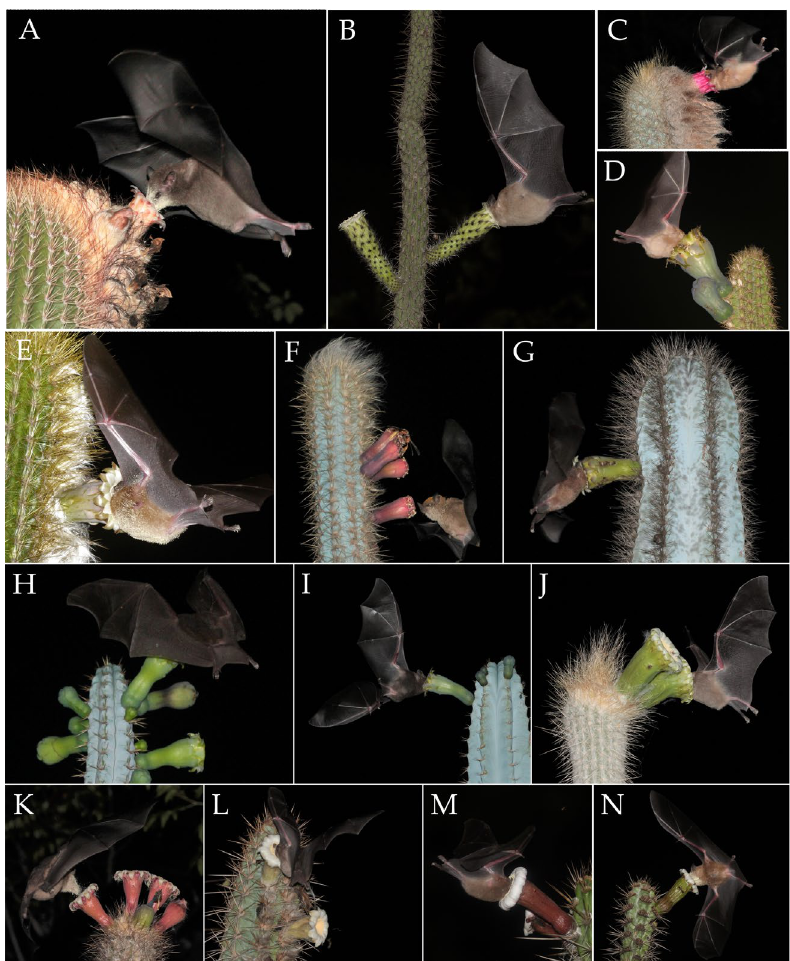
Figure 5. Nectarivorous bats visiting the taxa of Cereinae studied. ( A ) Coleocephalocereus goebelianus , ( B ) Leocereus bahiensis , ( C ) Micranthocereus purpureus , ( D ) Pilosocereus catingicola , ( E ) P. catimbauensis , ( F ) P. glaucochrous , ( G ) P. pachycladus , ( H ) P. pentaedrophorus subsp. pentaedrophorus , ( I ) P. pentae- drophorus subsp. robustus , ( J ) Stephanocereus leucostele , ( K ) S. luetzelburgii , ( L ) Xiquexique gounellei , ( M ) X. × heptagonus , and ( N ) X. tuberculatus